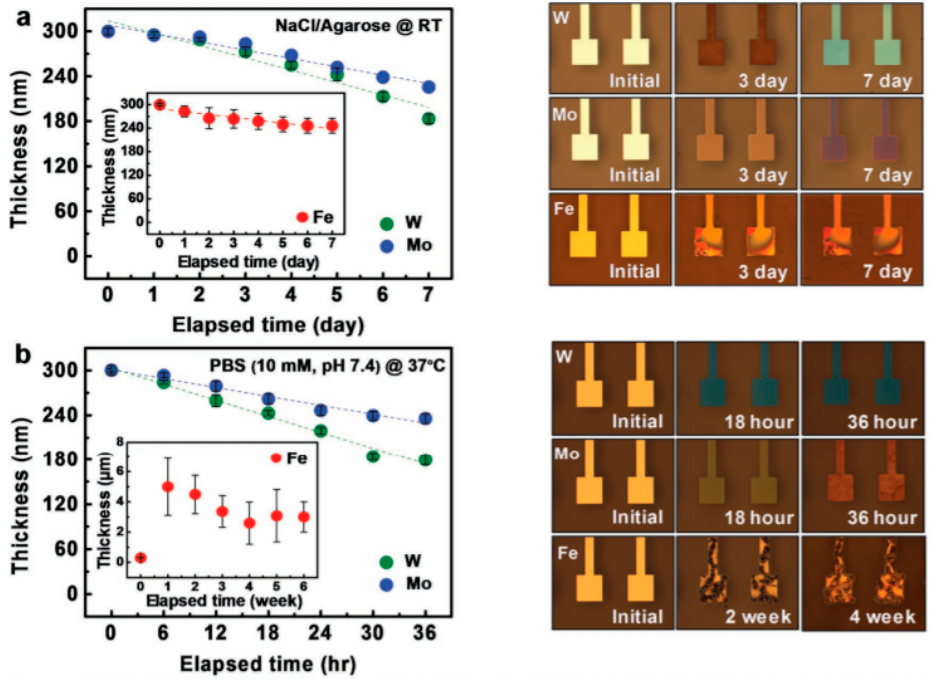
Figure 27. ( Left ) Dissolution kinetics ( a ) at room temperature and ( b ) at 37°C of the metal (W, Mo and Fe) thin films, in phosphate-buffered saline and with the agarose gel on top. ( Right ) optical images at several times. Adapted from [119]. Copyright © 2017 Wiley and Sons. Sensors 2020 , X , x FOR PEER REVIEW